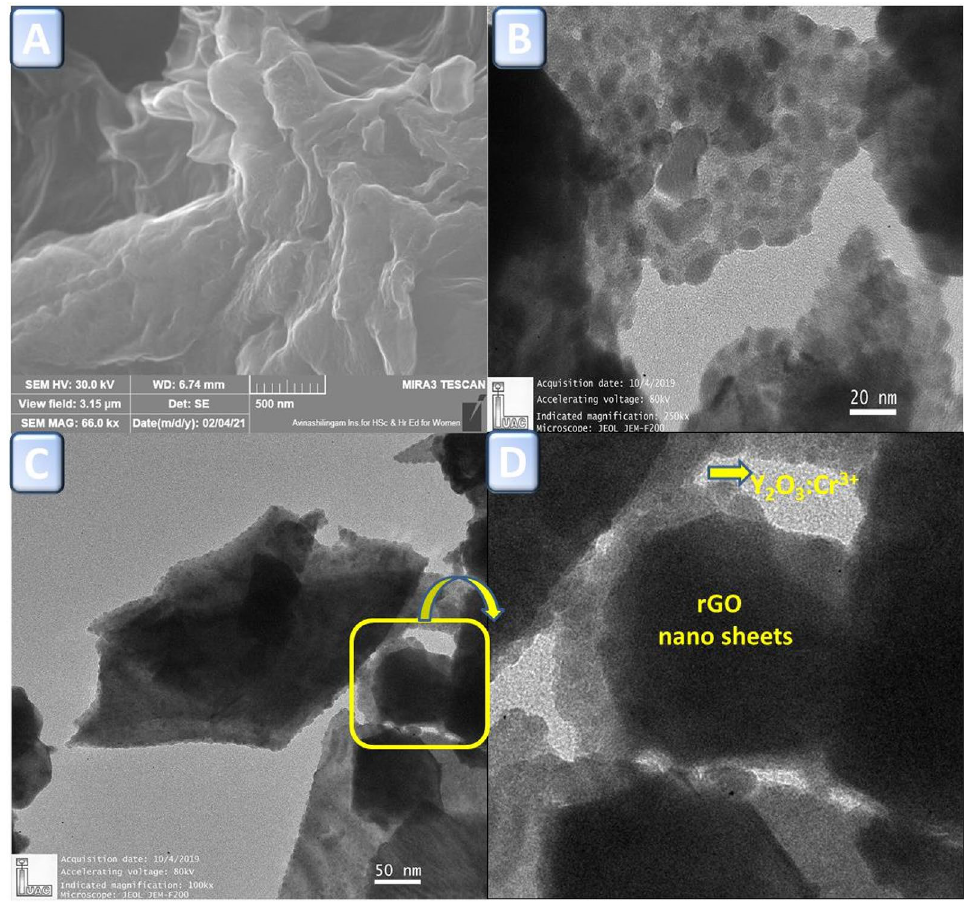
Figure 2. (A ) FESEM image of rGO nanosheet, ( B ) TEM image of Y 2 O 3 :Cr 3+ NPs, ( C ) TEM image of rGO/ Y 2 O 3 :Cr 3+ NCs . (D ) Enlarged image of rGO/Y 2 O 3 :Cr 3+